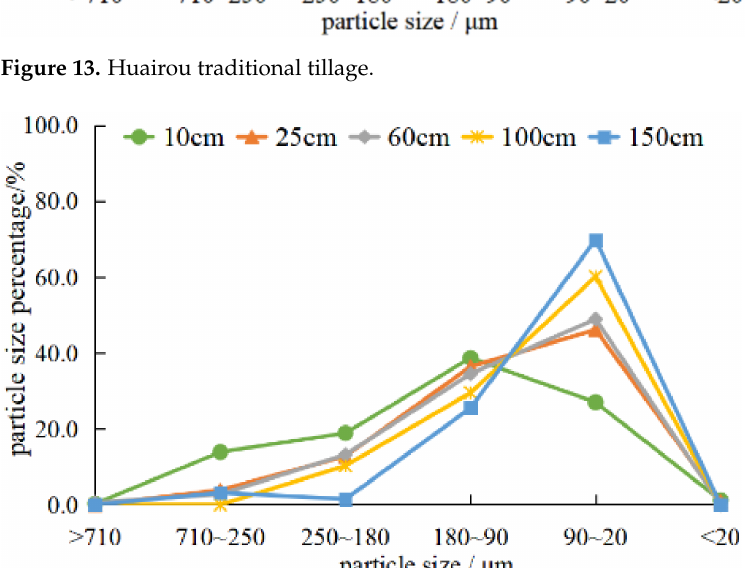
Figure 14. Yanqing traditional